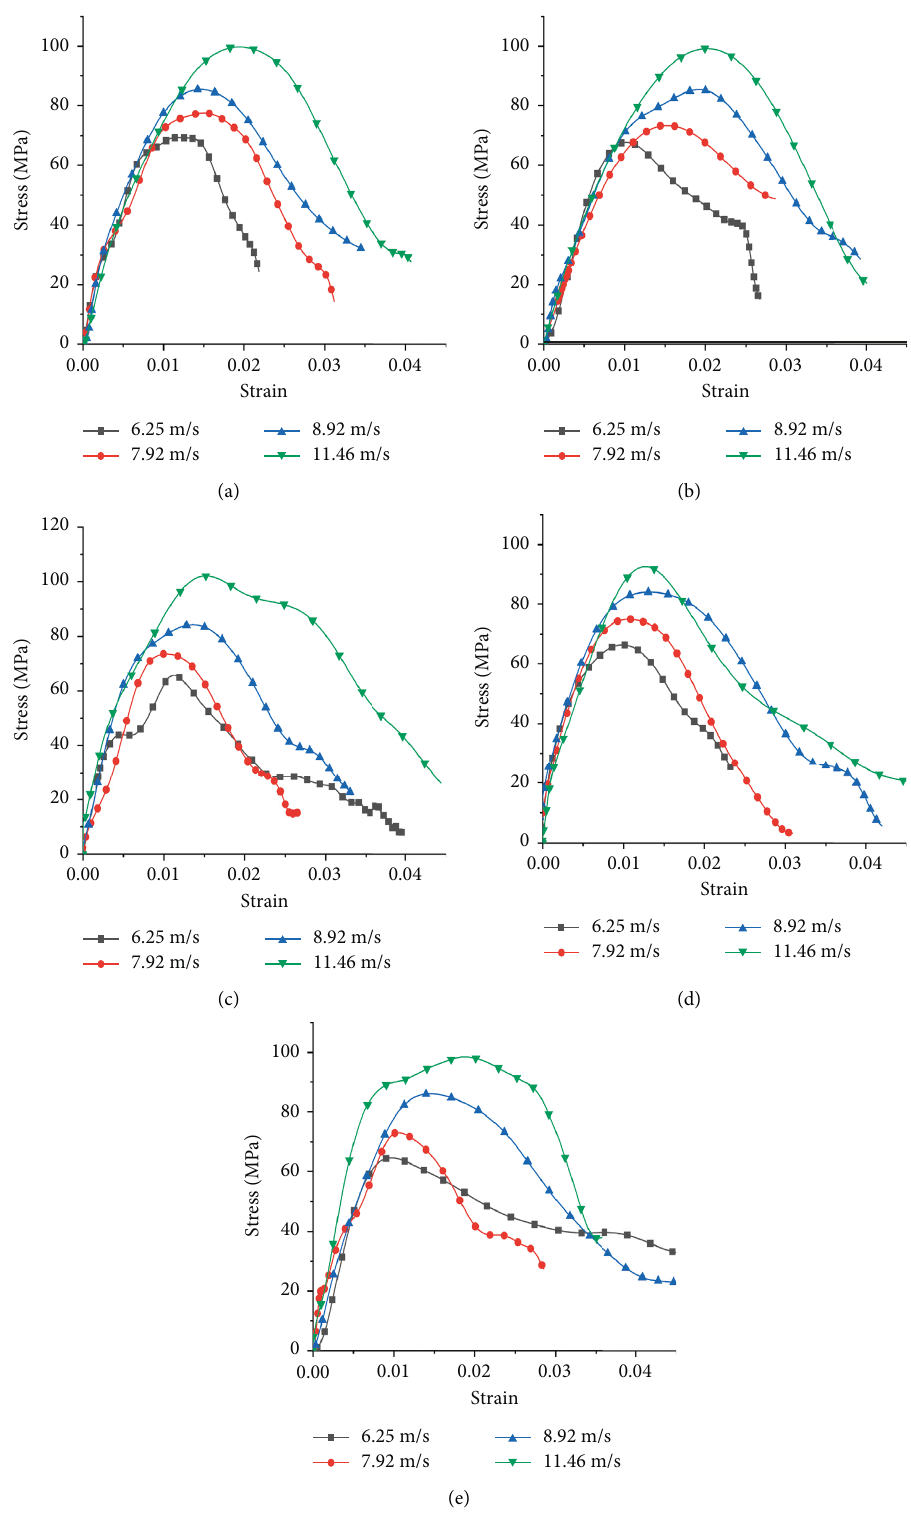
Figure 8: Stress-strain curve of specimen under dynamic compression. (a) FT0. (b) FT25. (c) FT50. (d) FT75. (e)